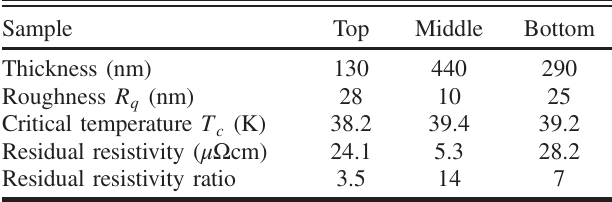
TABLE. I. Comparison of the characteristics obtained for the three samples mounted on the stainless steel tube.